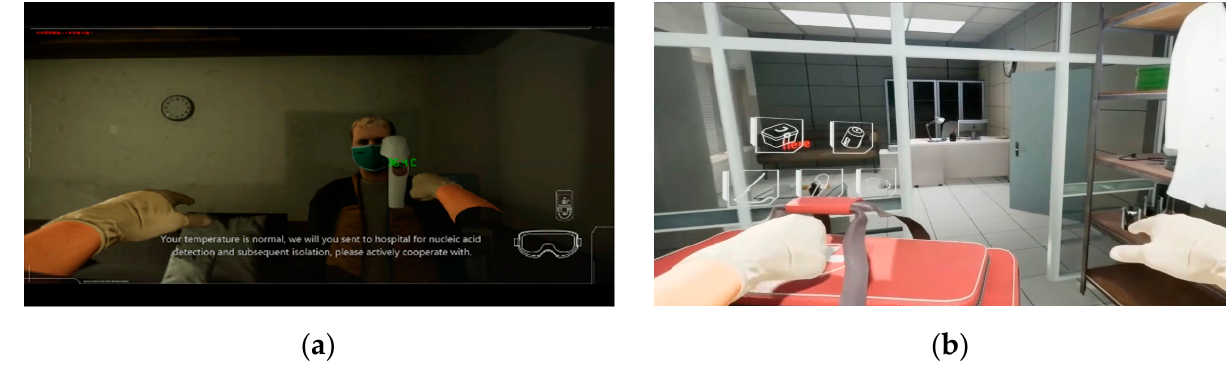
Figure 6. Gaming UI: ( a ) HUD UI with using medical tool [9]; ( b ) HUD UI with carrying medical package and 3D indication